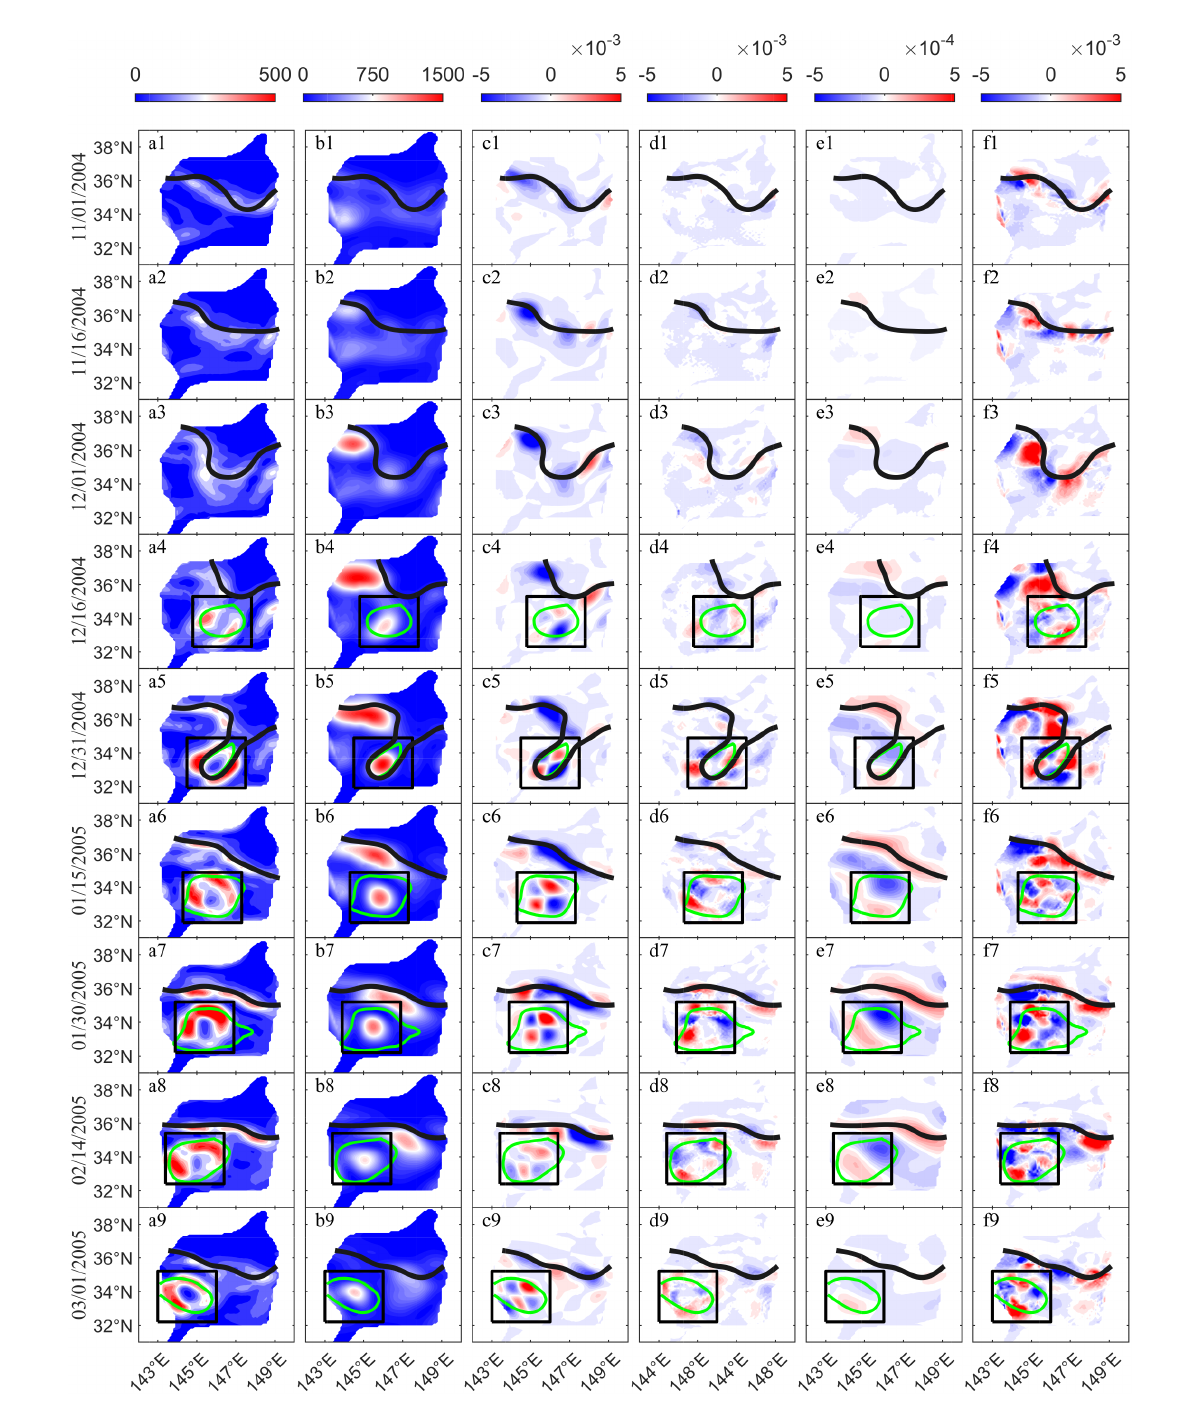
FIGURE 7 Daily maps of (A) eddy kinetic energy (EKE, m 3 /s 2 ), (B) eddy potential energy (EPE, m 3 /s 2 ), (C) baroclinic conversion (BC, m 2 /s 2 ), (D) barotropic conversion (BT, m 2 /s 2 ), (E) wind stress work (WW, m 2 /s 2 ), and (F) advective term (ADV, m 2 /s 2 ) patterns. The black line represents the Kuroshio axis, the green circle marks the eddy boundary, and the black box is a 3° × 3° concentric square with the